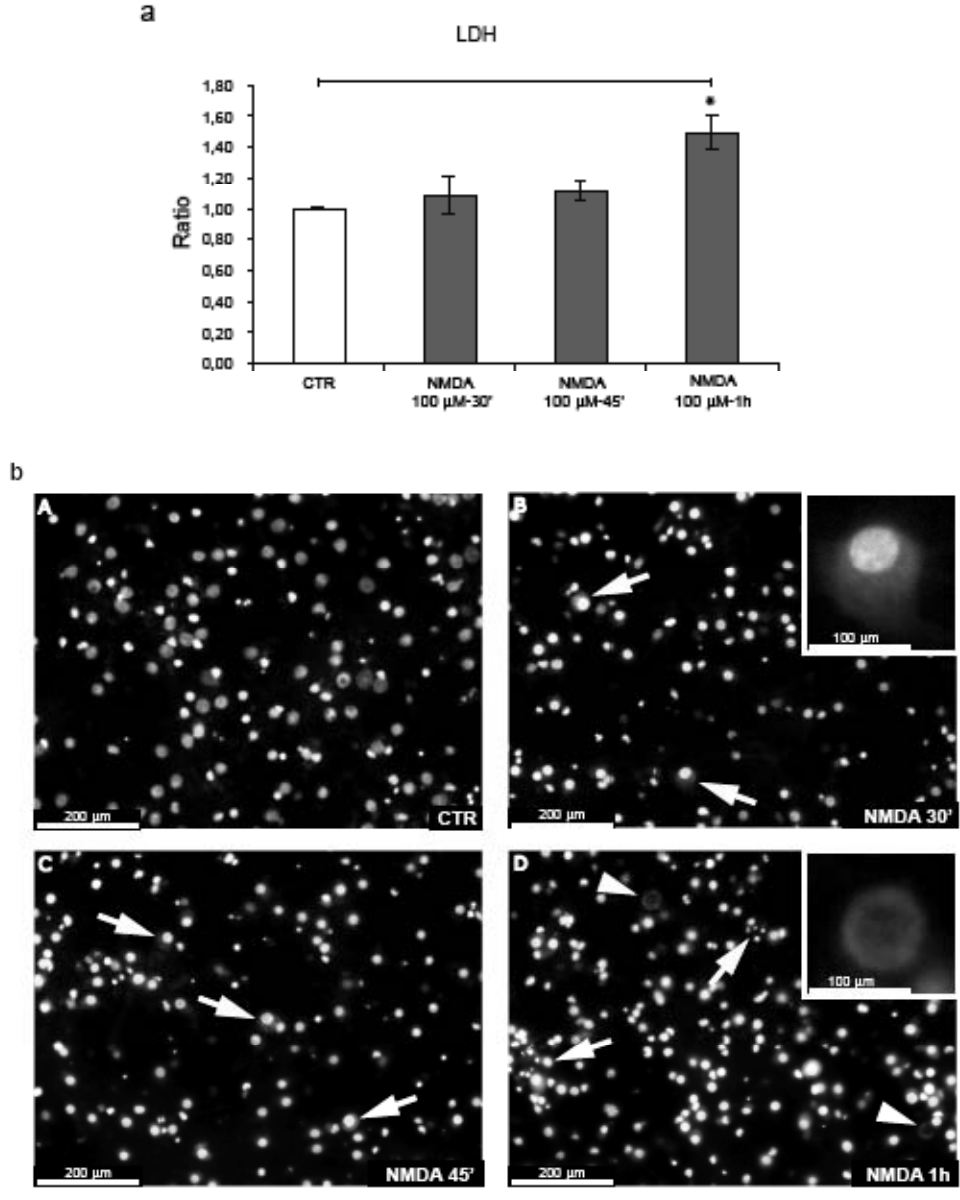
Figure 1. Neuronal death is not induced after 30’-45’ NMDA application. (a) Neurons were exposed to NMDA (30’-45’-1 h) and neuronal viability was assessed by LDH assay. NMDA-1h significantly increased neuronal death. Quantification is from five independent experiments (±S.E.M.), (* p < 0.05). (b) Hoechst staining of neurons exposed to NMDA. At 30’-45’, NMDA induces some neuronal swelling (arrows fig. B-C, magnification 20 × and higher magnification (40 ×) in the box B). After 1 h some neurons undergo nuclear fragmentation (arrows fig. D) while we can also note the presence of the first “ghost” neuron (arrowheads fig. D; higher magnification (40 ×) in the